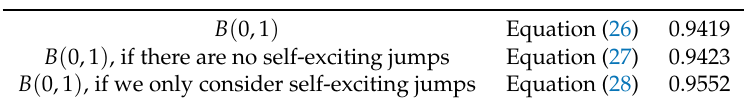
Table 5. Bond price B ( 0,1 )